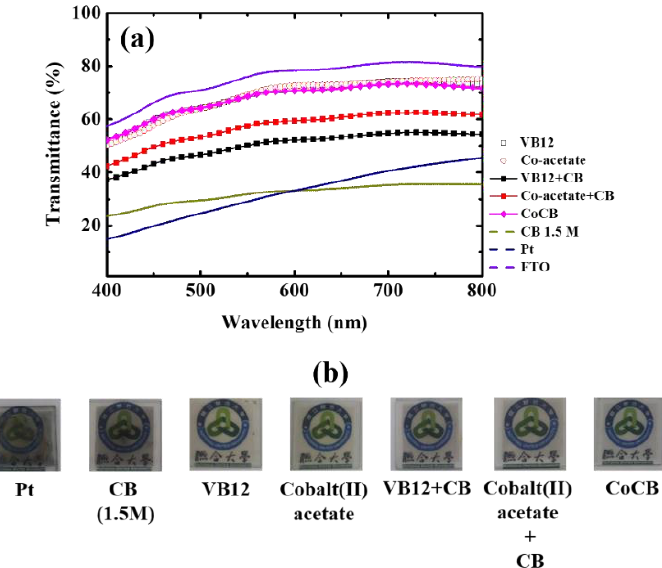
Figure 2. ( a ) Transmittance spectra and ( b ) photographs of various CEs.